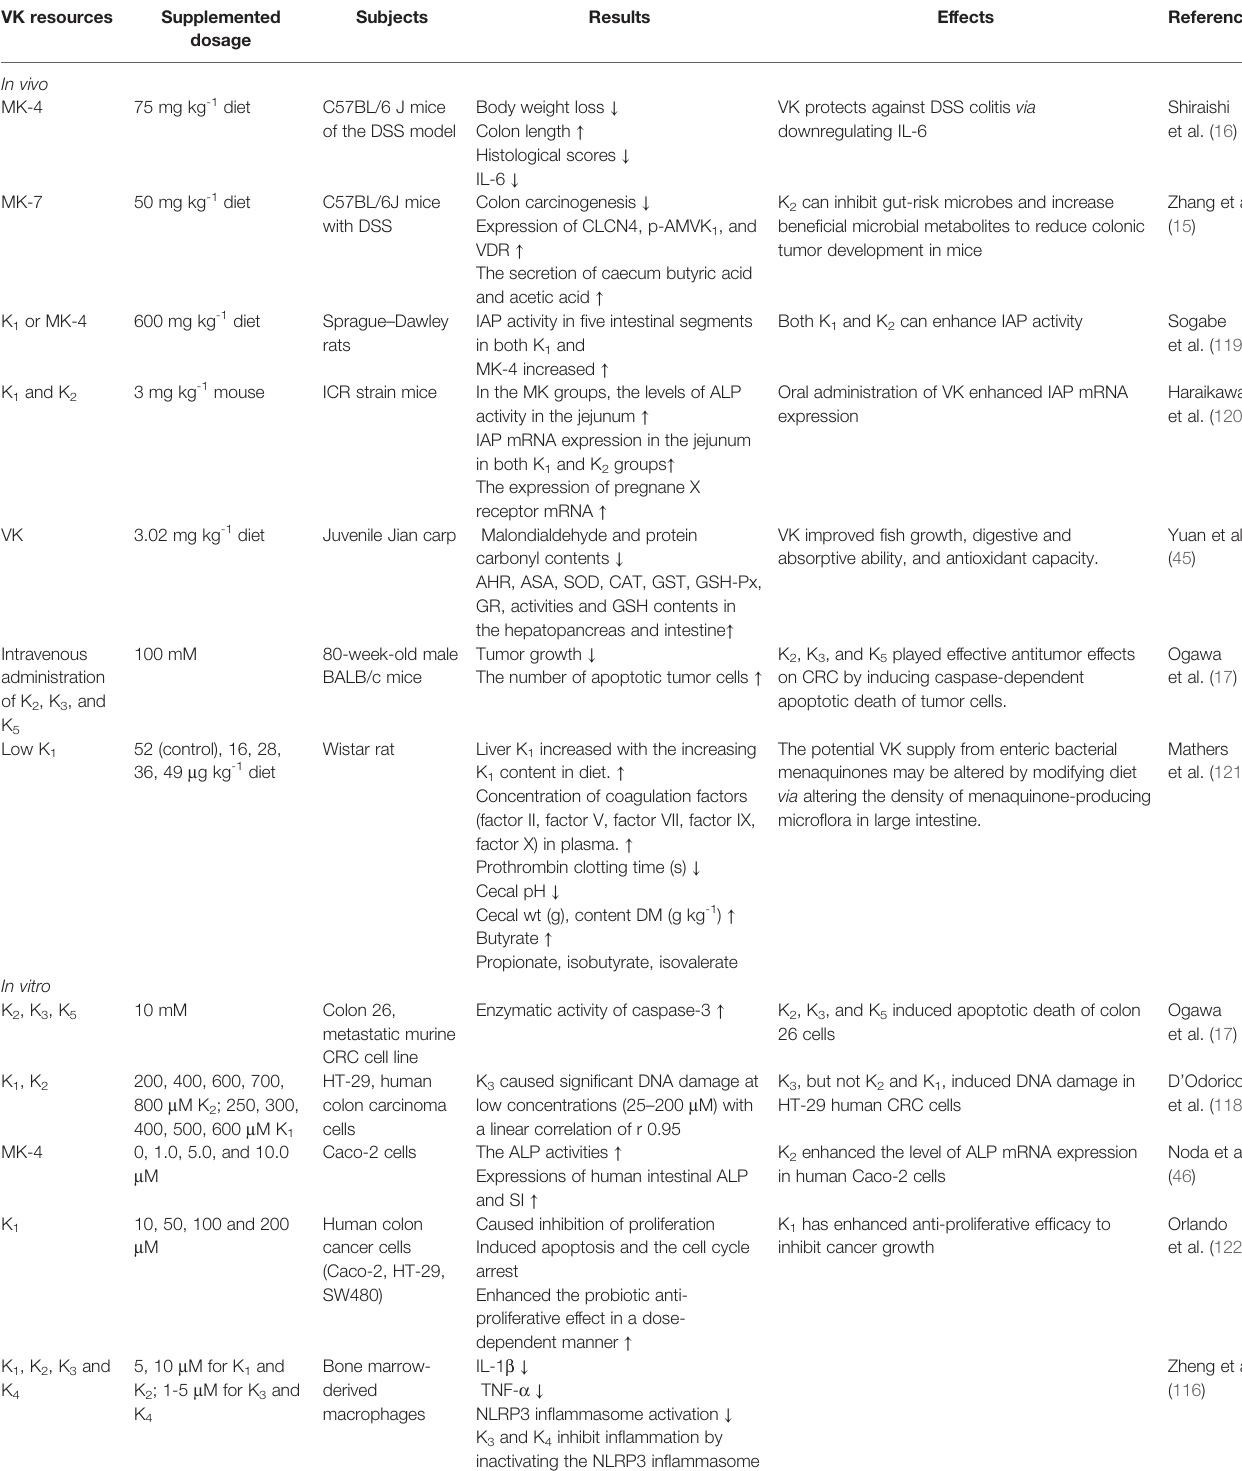
TABLE 1 | Effects of different sources of VK on intestinal homeostasis (without bacteria information) of patients or animals in vivo and in vitro